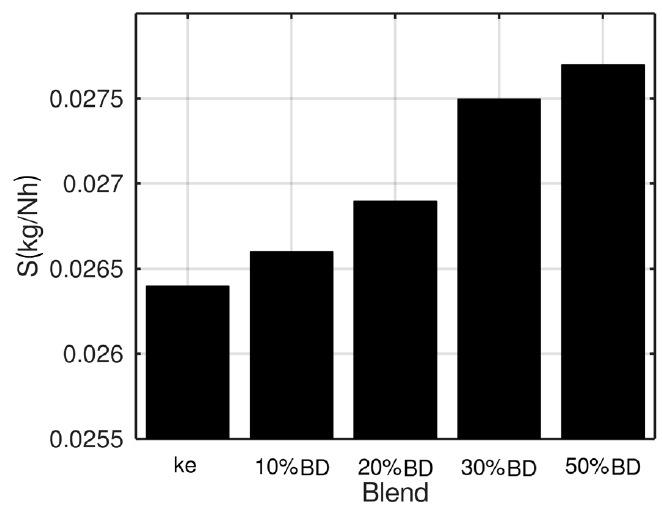
Figure 16. Variation of specific consumption for all tested blends at the maximum regime.